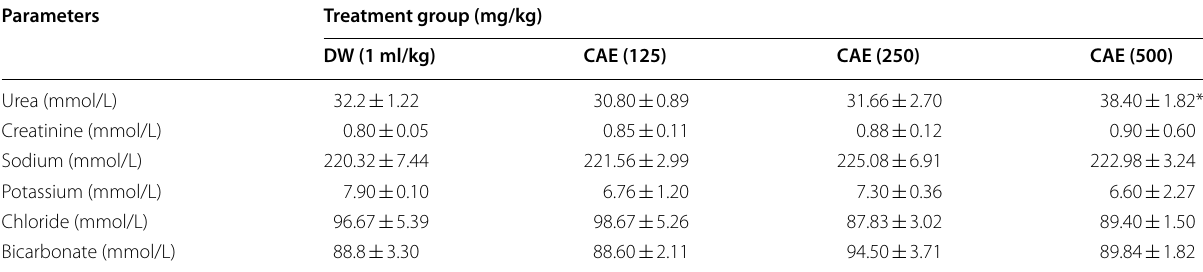
SEM; * p 0.05 compared to control group (one-way ANOVA followed by Dunnett’s post hoc test), n ± ≤